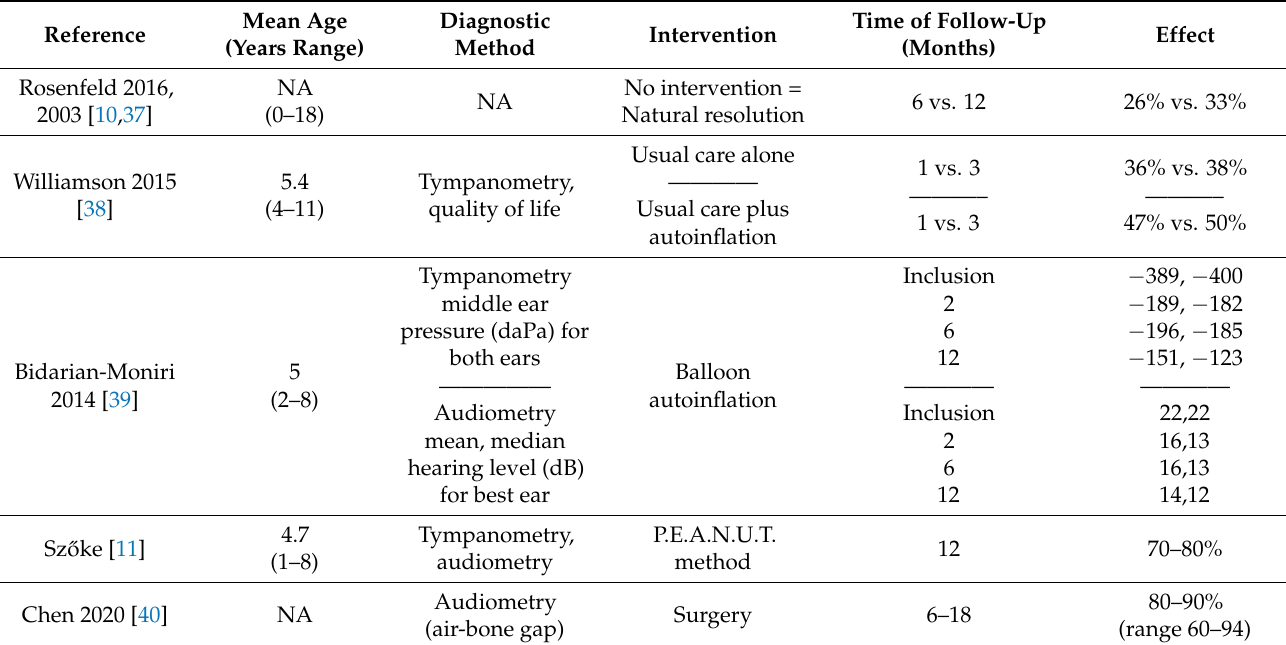
Table 6. Effect of different interventions in chronic otitis media with effusion